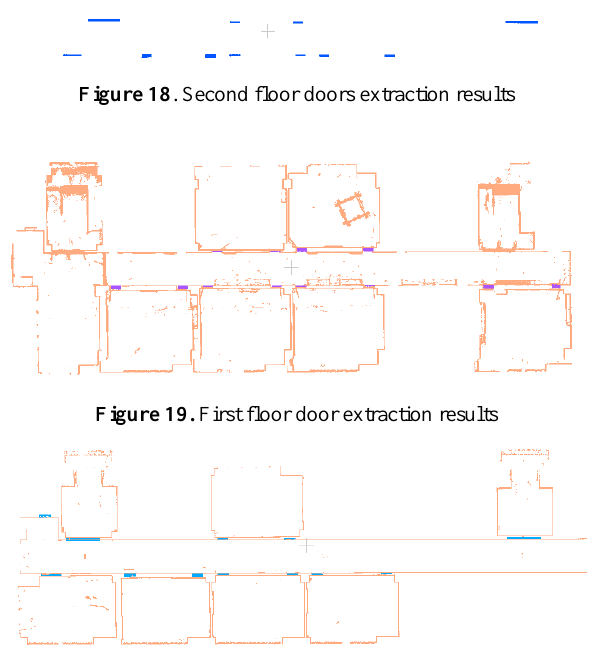
Figure 20 . Second floor door extraction